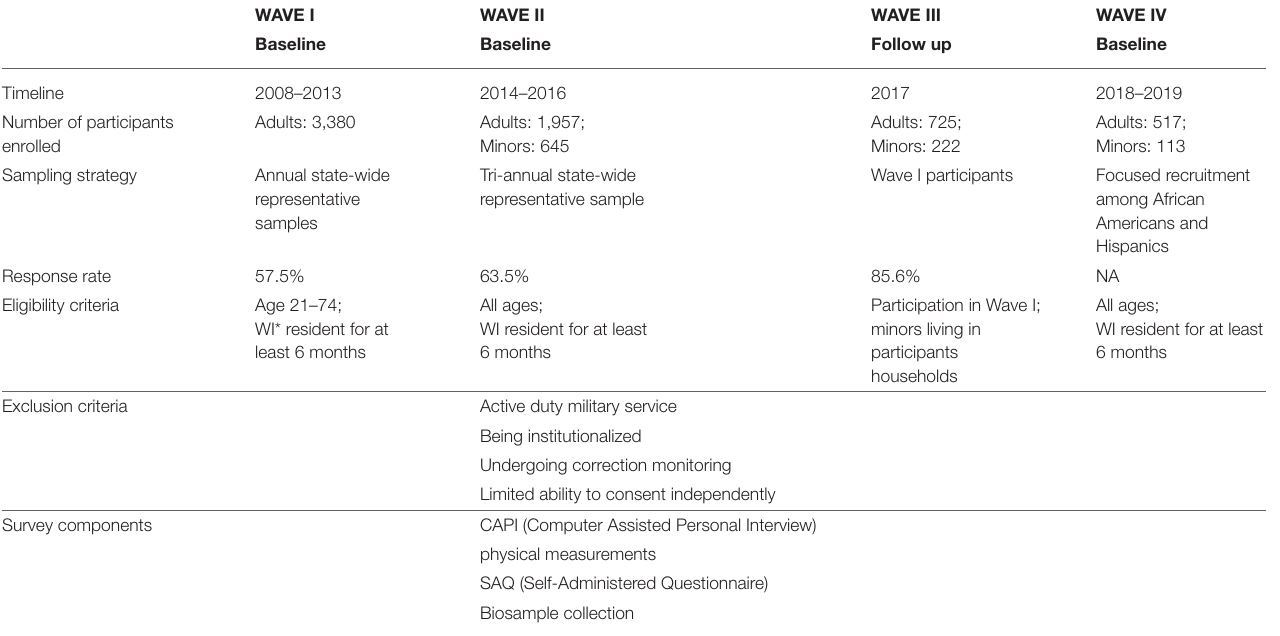
TABLE 3 | SHOW survey participant summary, sampling strategy and components by